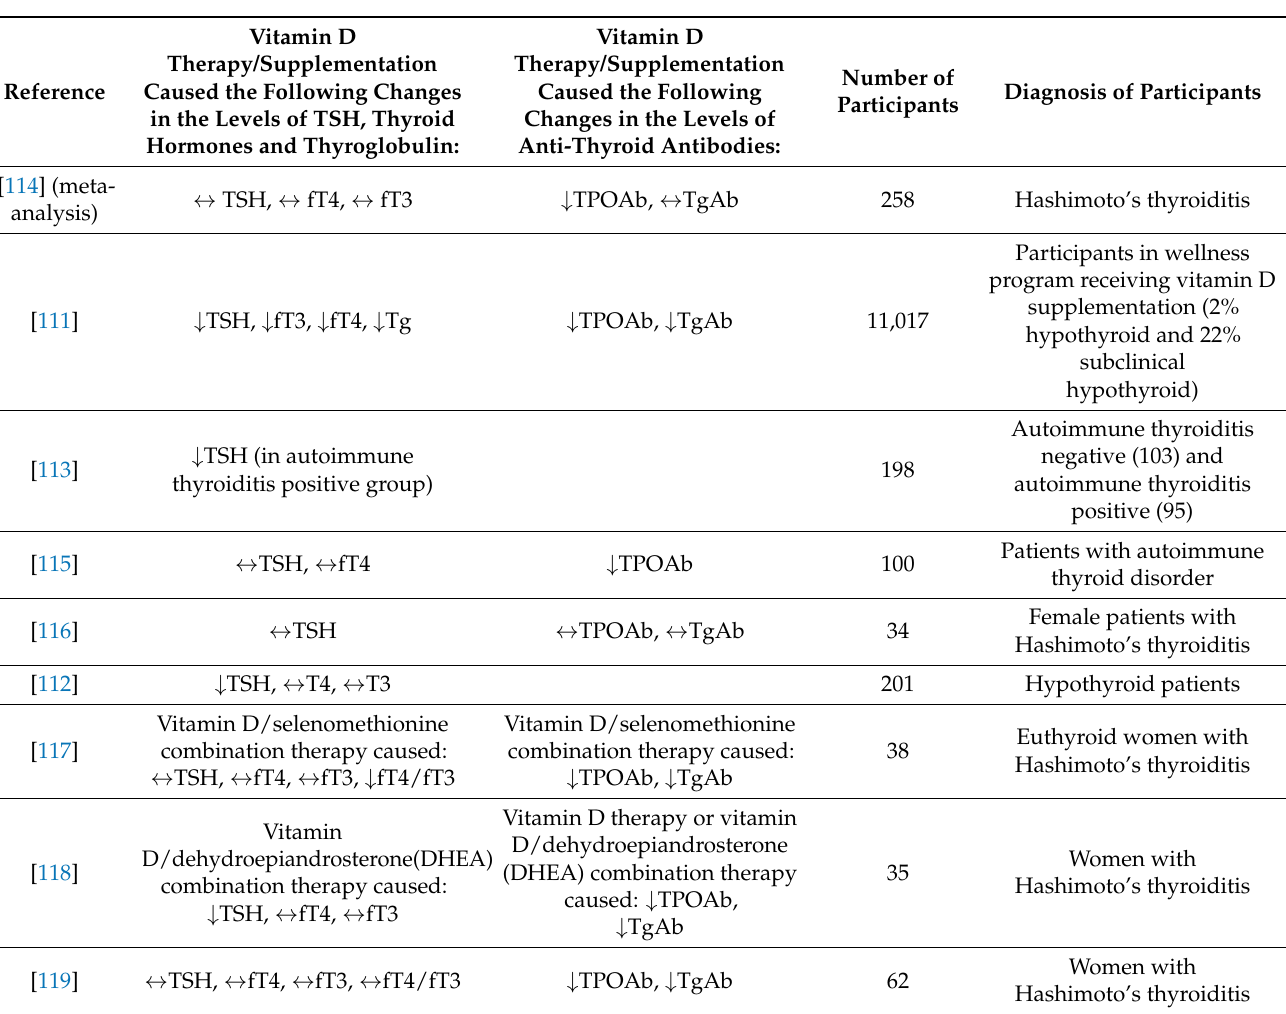
Table 2. Changes in the levels of TSH, thyroid hormones, thyroglobulin and anti-thyroid antibodies following vitamin D (cholecalciferol)